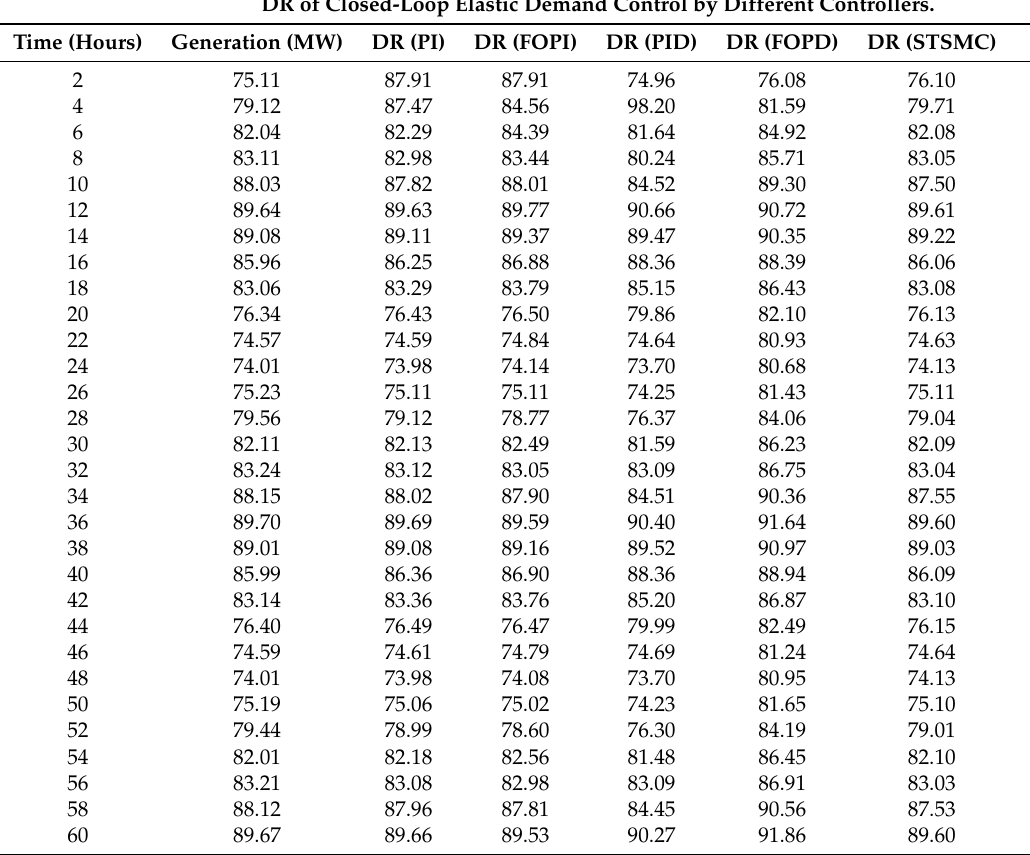
Table 3. Comparison DR of the closed-loop STSMC with PI [14], FOPI [43], PID [43] and FOPI demand response in tracing the generation. DR of Closed-Loop Elastic Demand Control by Different Controllers.